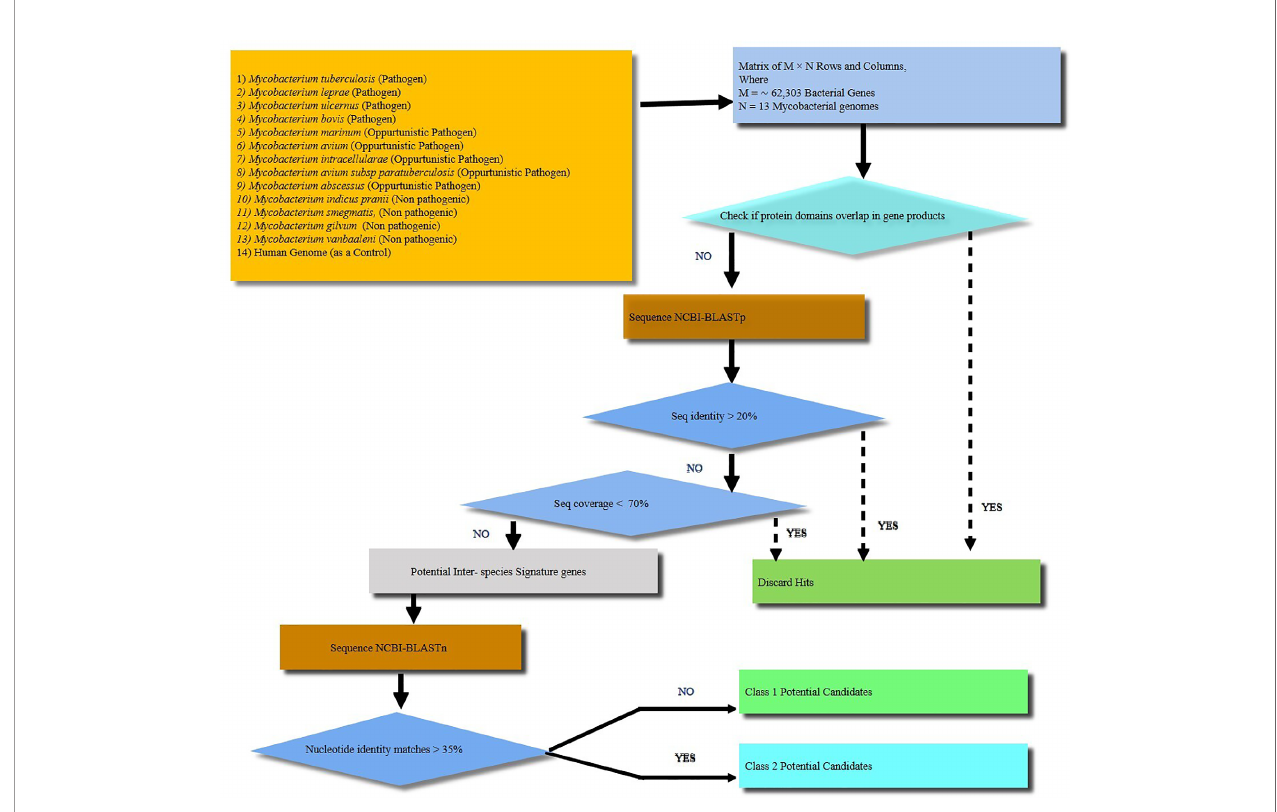
FIGURE 1 | A schematic work fl ow showing identi fi cation of signature proteins of Mycobacterium tuberculosis ( M.tb ) based on computational analysis by comparing 13 mycobacterial species including strict pathogens, opportunistic pathogens and non-pathogenic mycobacteria. Human genome was taken as a control. A total of about 62,303 genes were analyzed. The M. tb genes with overlapping/similar protein domains to other species were omitted for further analysis. The rest of genes were then checked for protein sequence similarity analysis using protein BLAST (BLASTp). All the genes with protein sequence identity less than 20% were further analyzed for nucleotide sequence similarity. Nucleotide sequence similarity was analyzed using BLASTn and genes with less than 35% of nucleotide similarity were considered as potential signature candidates. Finally, out of the potential candidates Rv1509 emerged as a ‘ signature ’ of